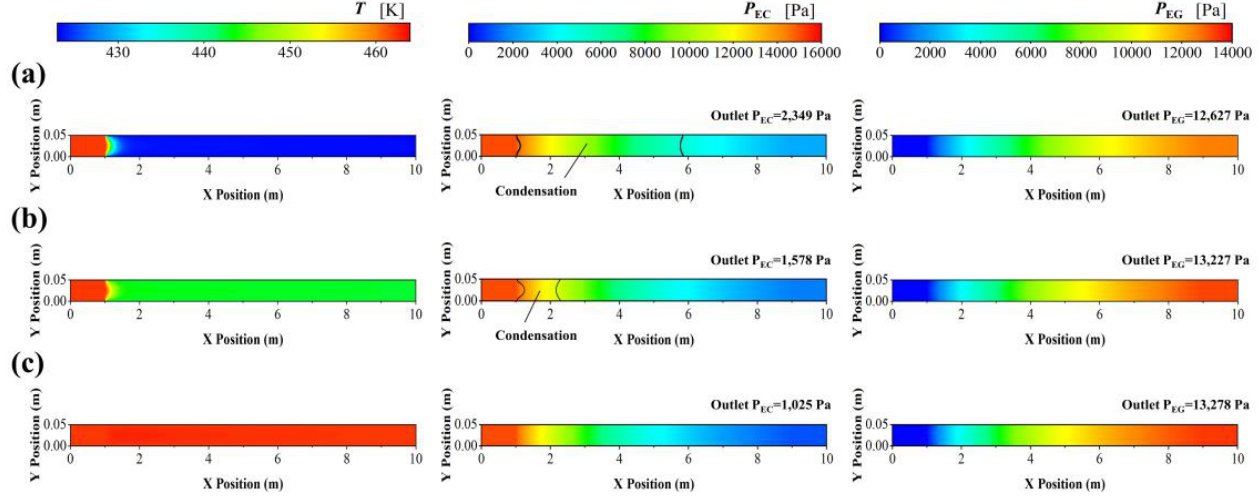
Figure 5. Contours of T , P EC and P EG in boiling water-cooled reactor with different coolant tem- peratures of ( a ) 423 K, ( b ) 443 K and ( c ) 463 K under the conditions of 3 MPa, 0.3 g EC · gcat − 1 · h − 1 , H 2 /EC = 200 and reactant inlet temperature of 463